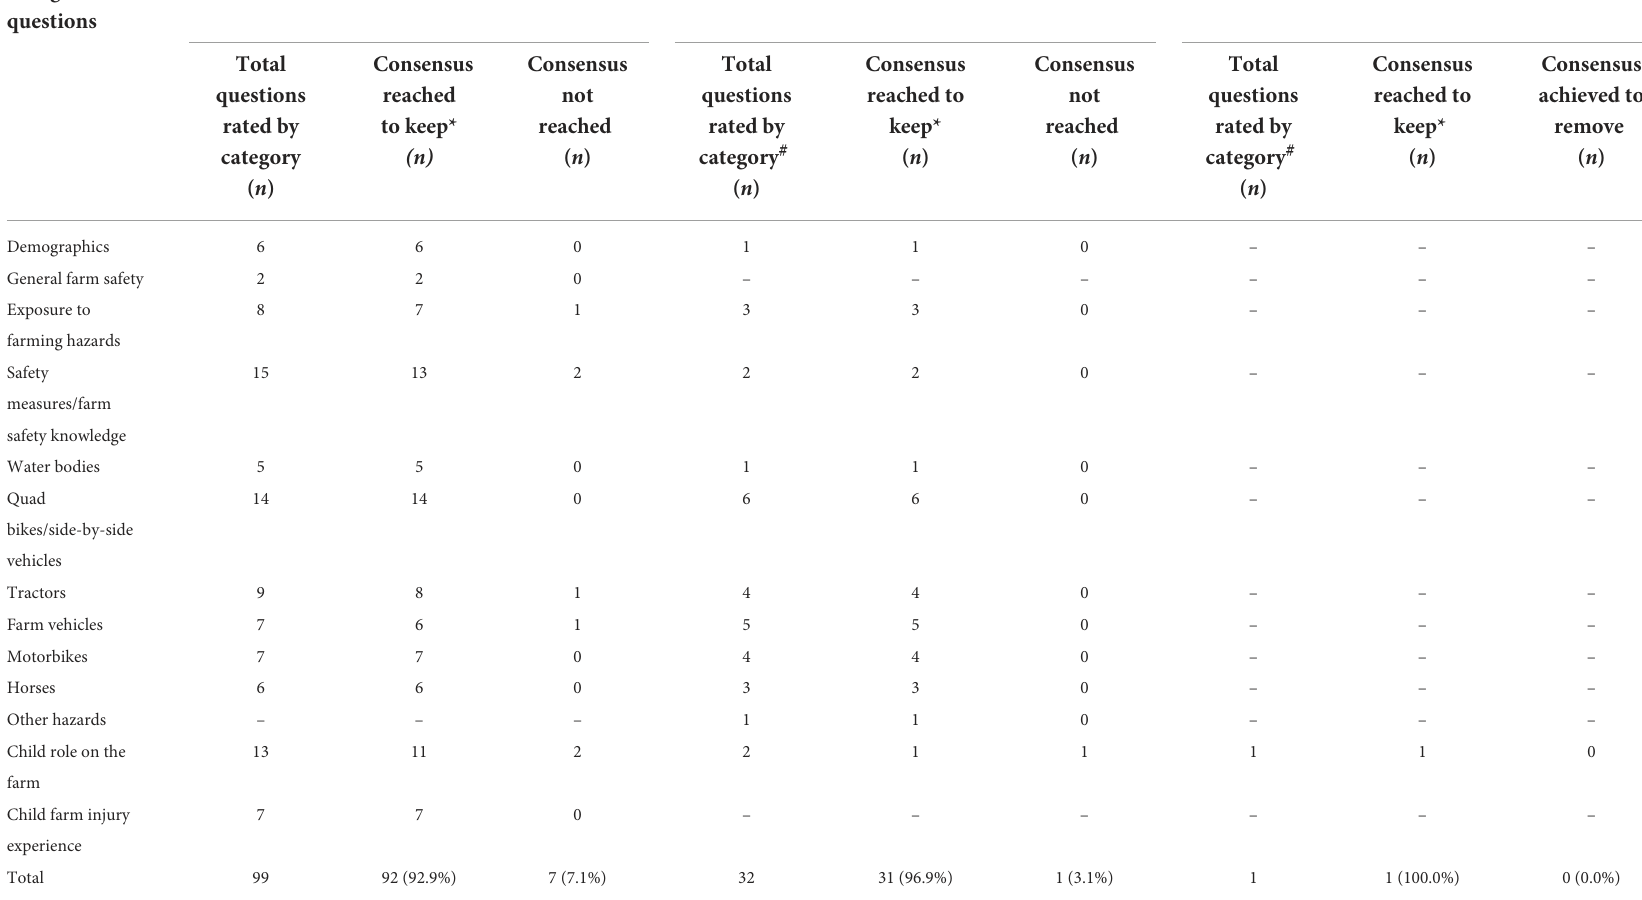
TABLE 3 Results of the Delphi method consensus process for the child survey by round and question category. Categories